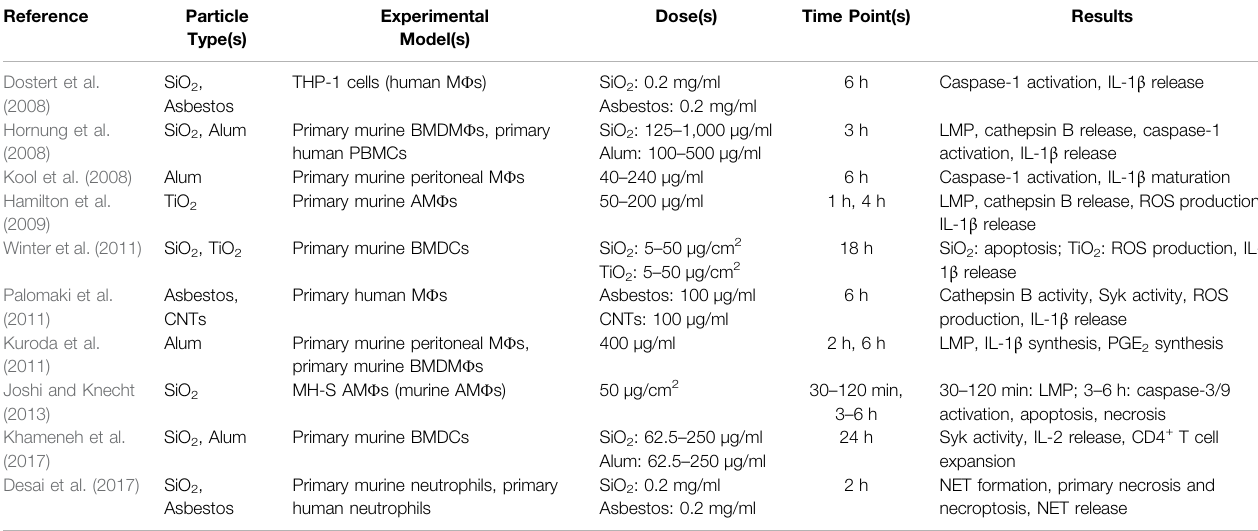
TABLE 2 | Examples of studies demonstrating toxic responses of exogenous particles.